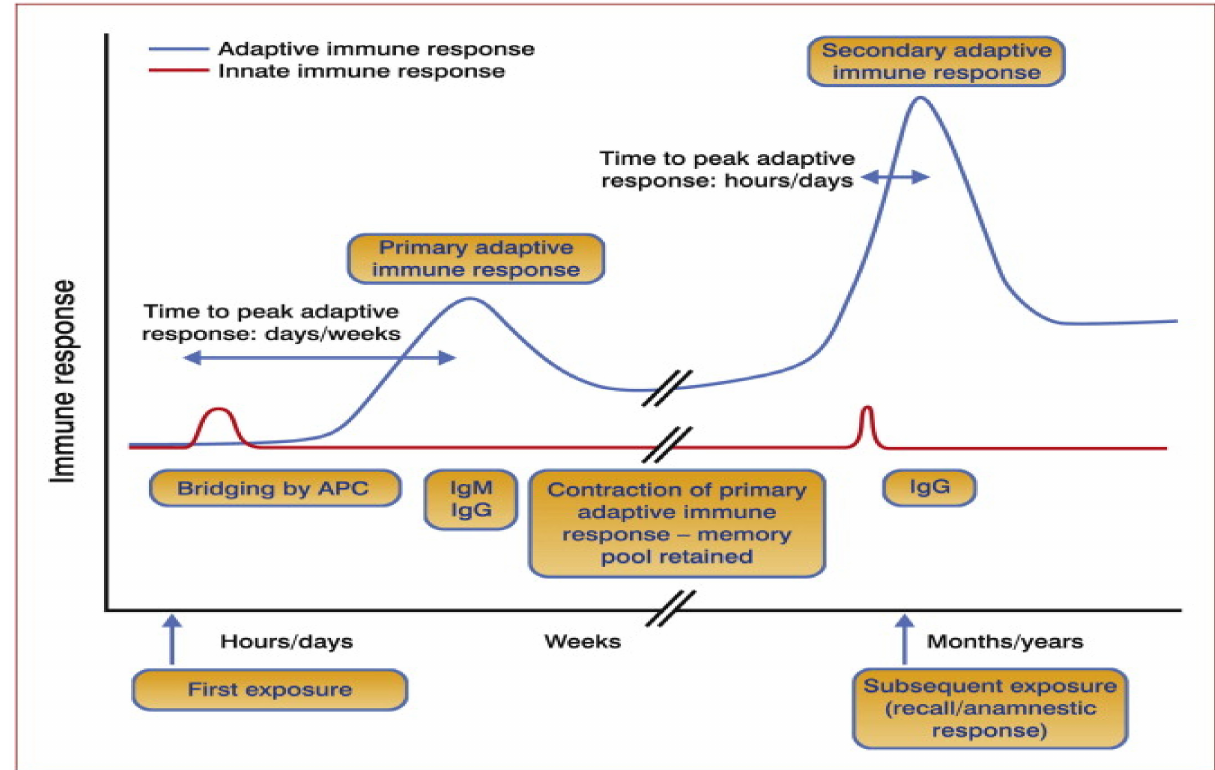
Figure 3. Illustration of the humoral immune response kinetics curve adapted from Leo et al. [104].